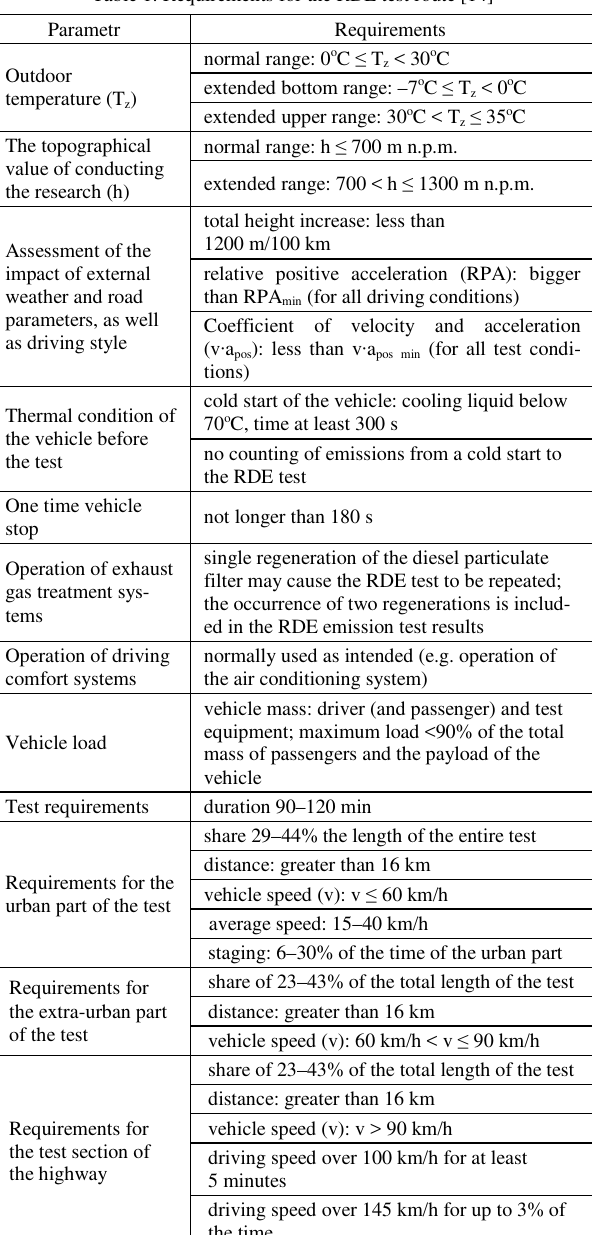
Fig. 3. Research apparatus